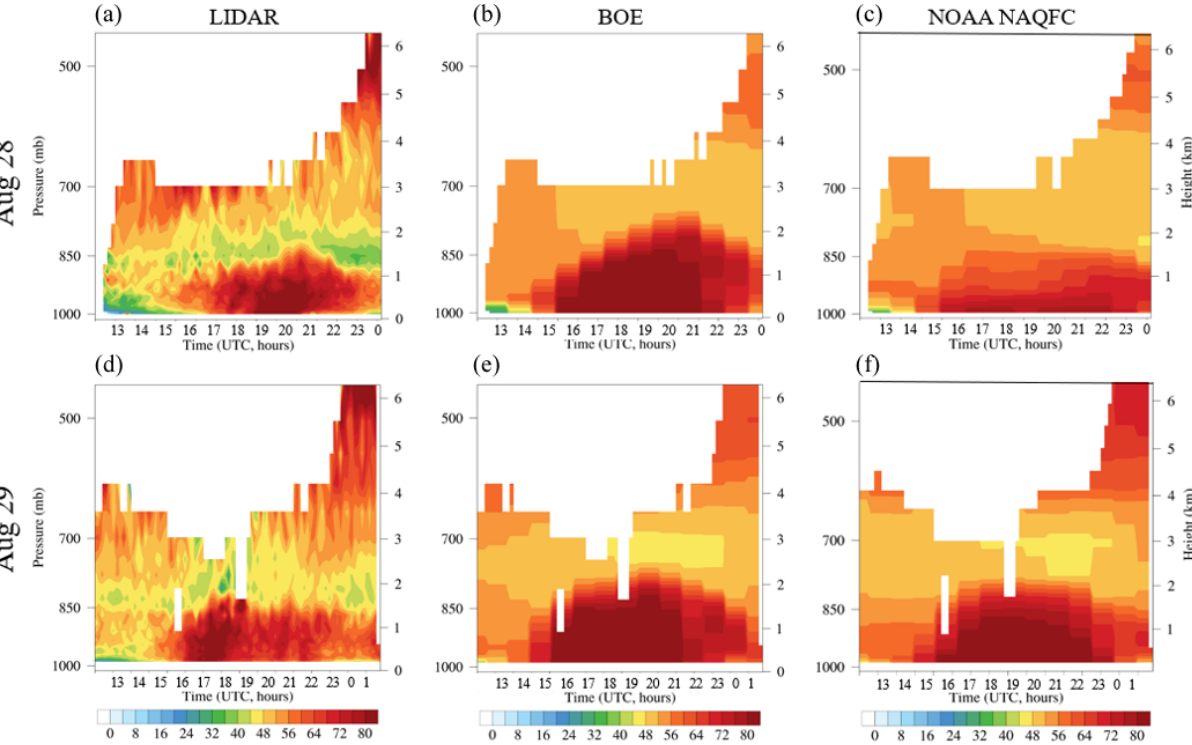
Figure 13. Comparison of vertical O 3 profiles (observed by NASA Langley Mobile O 3 Lidar (left column, a and d )) with these simulated by the 3km prediction system (central column, b and e ) and the 12km NOAA NAQFC (right column, c and f ) over the Westport site on 28 August ( a–c ) and 29 August 2018 ( d–f ), respectively. Note white represents missing data from the lidar